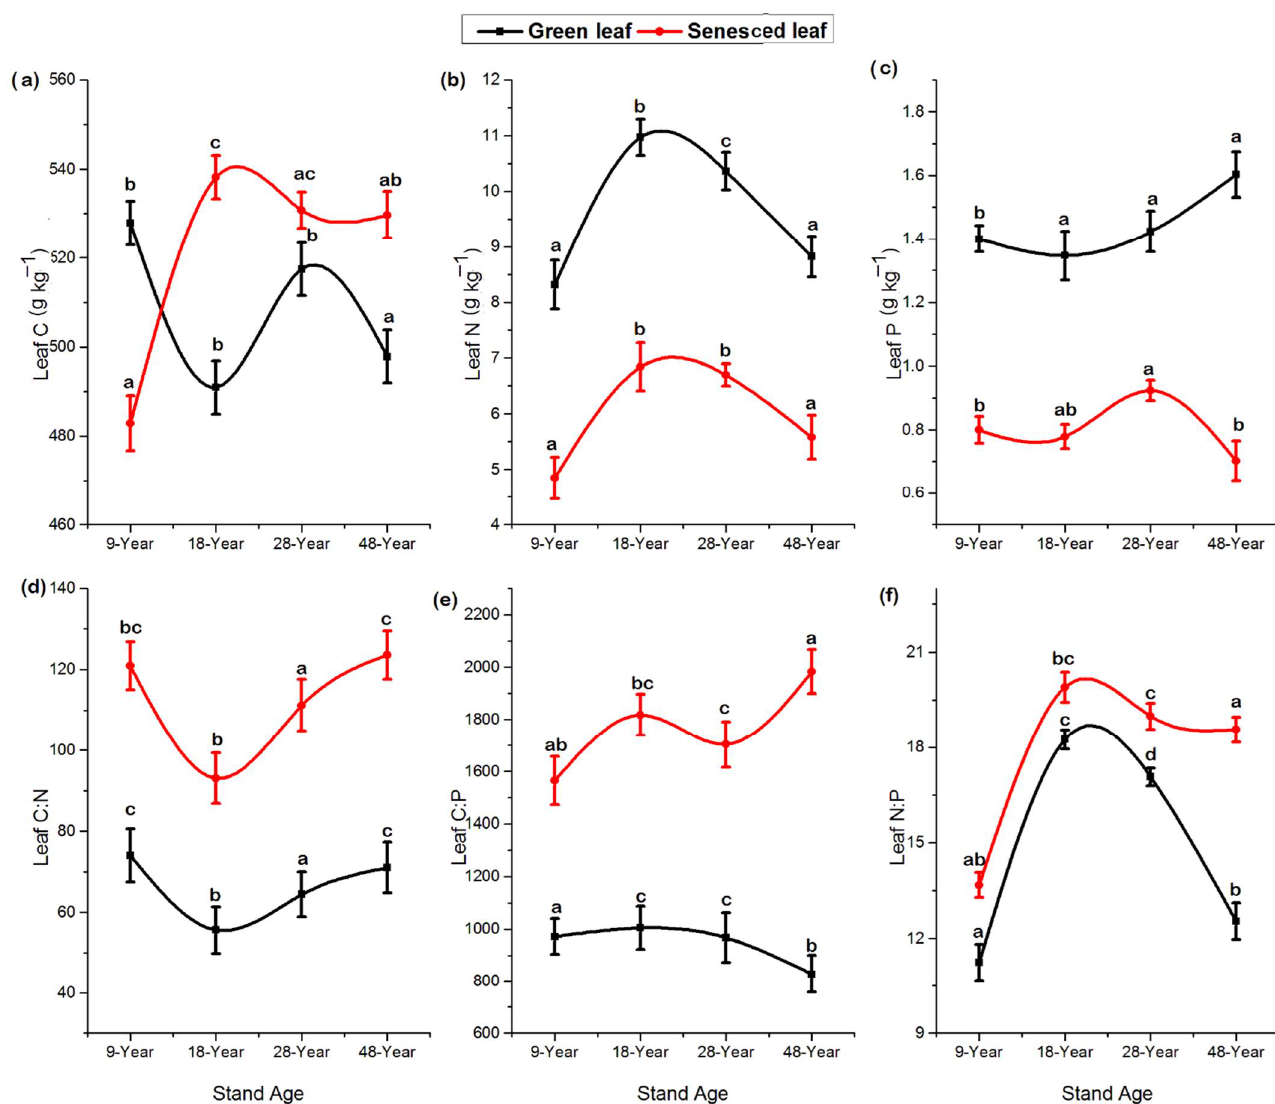
Figure 5. Change in the green and senesced leaf contents of C, N and P ( a – c ) and stoichiometric ratios ( d – f ) in a chronosequence of P. massoniana plantations. Error bars show standard error while the lines represent average value with three replicates ( n = 3), whereas the lower-case letters (a–d) represent the trend among stand age ( p < 0.05).